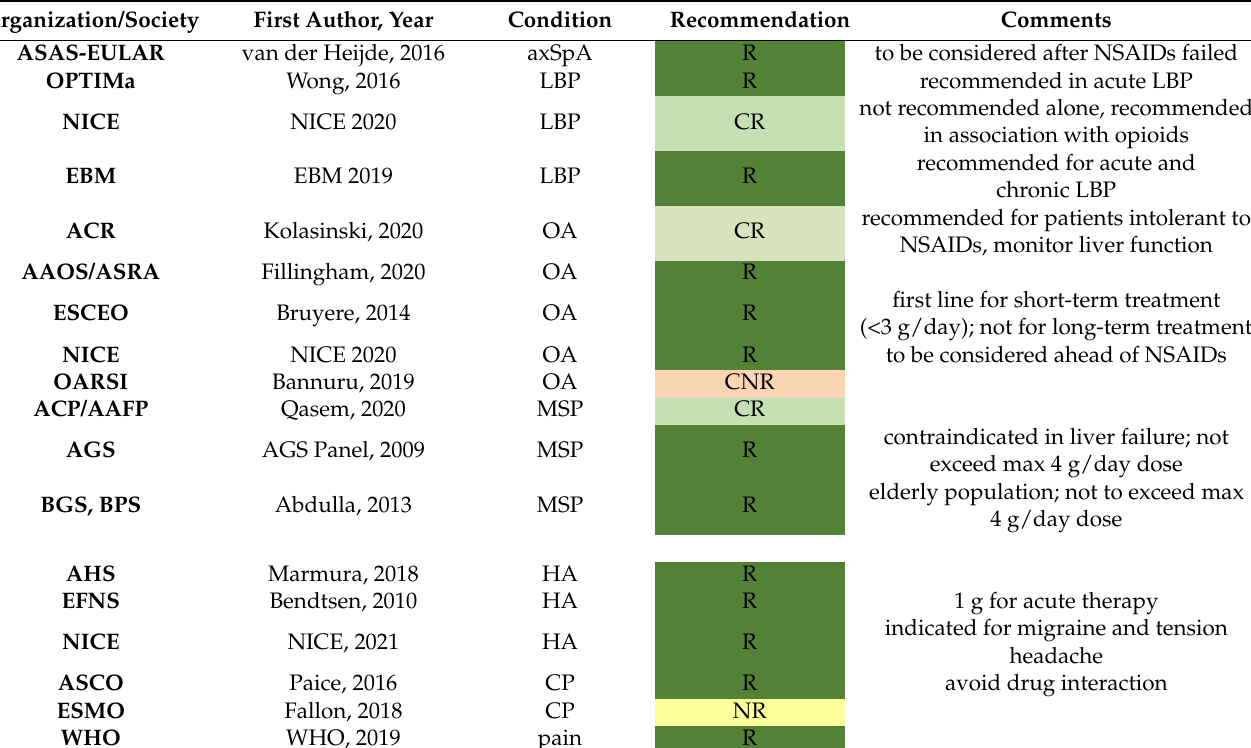
Table 3. Guideline recommendations for pain treatment with paracetamol.